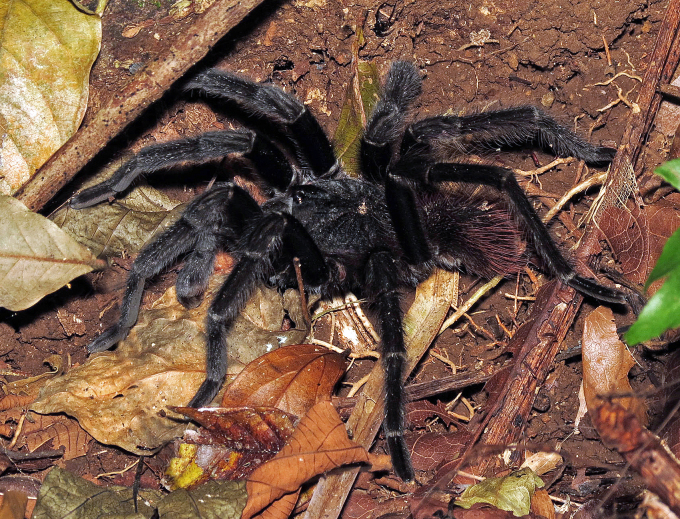
Sericopelma
embrithes (Chamberlin & Ivie, 1936) male from Barro Colorado Island, Panama. Photo: Katja Schultz.